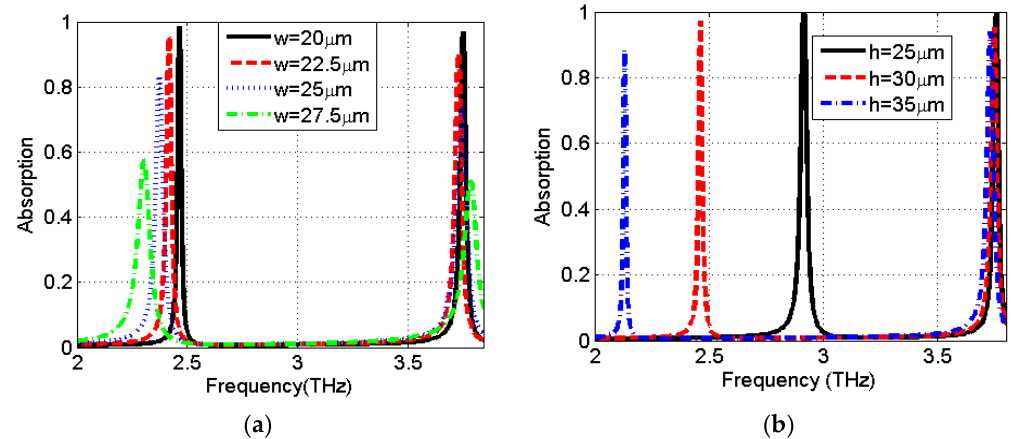
Figure 7. Absorption spectra of the proposed absorber of Figure 1 obtained by HFSS for various ( a ) width of holes ( b ) thickness of dielectric slab.